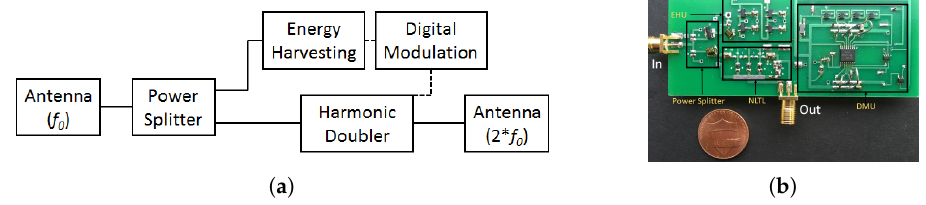
Figure 11. ( a ) Schematic block diagram of the harmonic RFID, and ( b ) implementation of the harmonic RFID circuit as in [24]. [Reproduced with permission from S. Mondal, A passive harmonic RFID tag and interrogator development; published by IEEE,